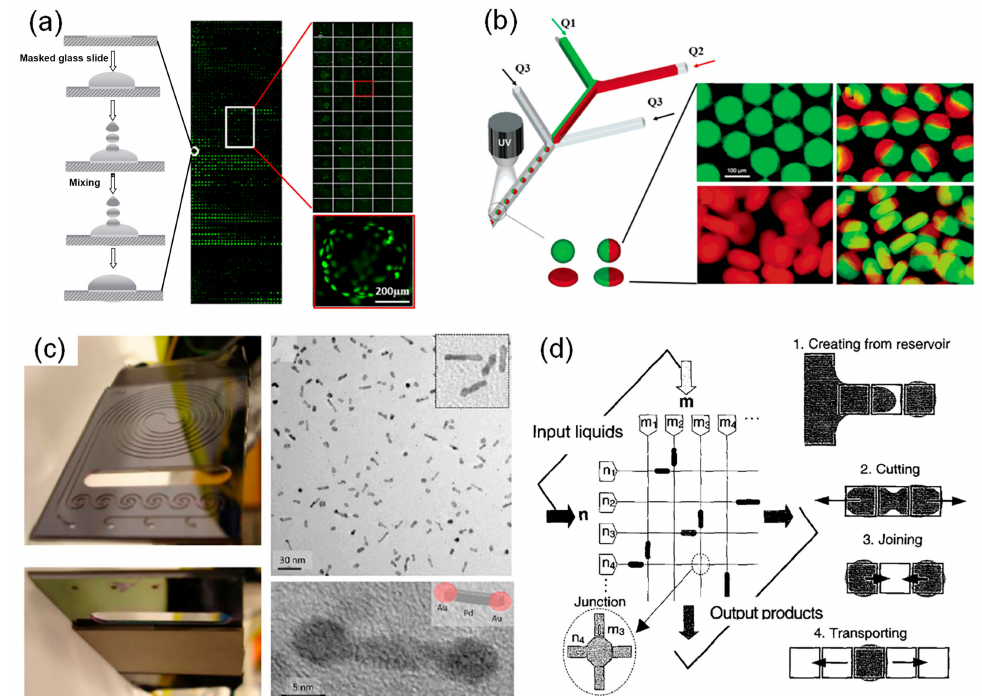
Figure 1. ( a ) A representative high-throughput platform (HTP) based on microarrays. A